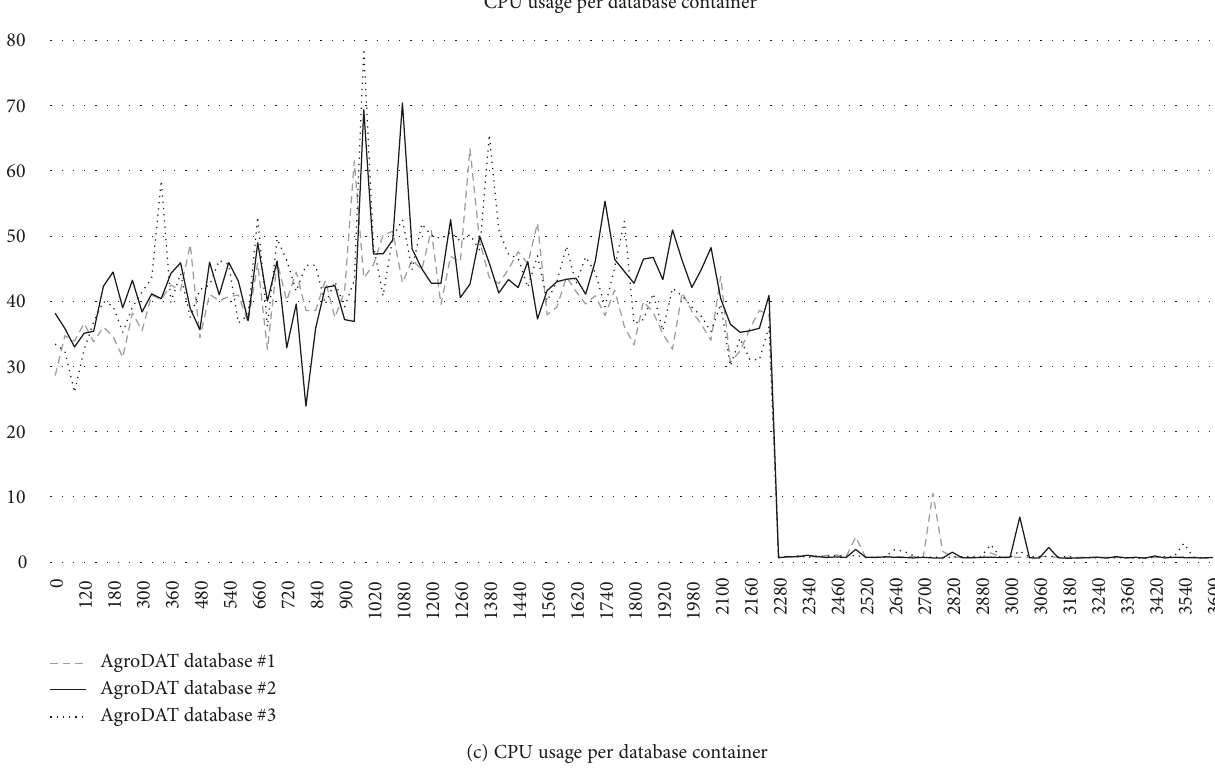
Figure 13: CPU usage per